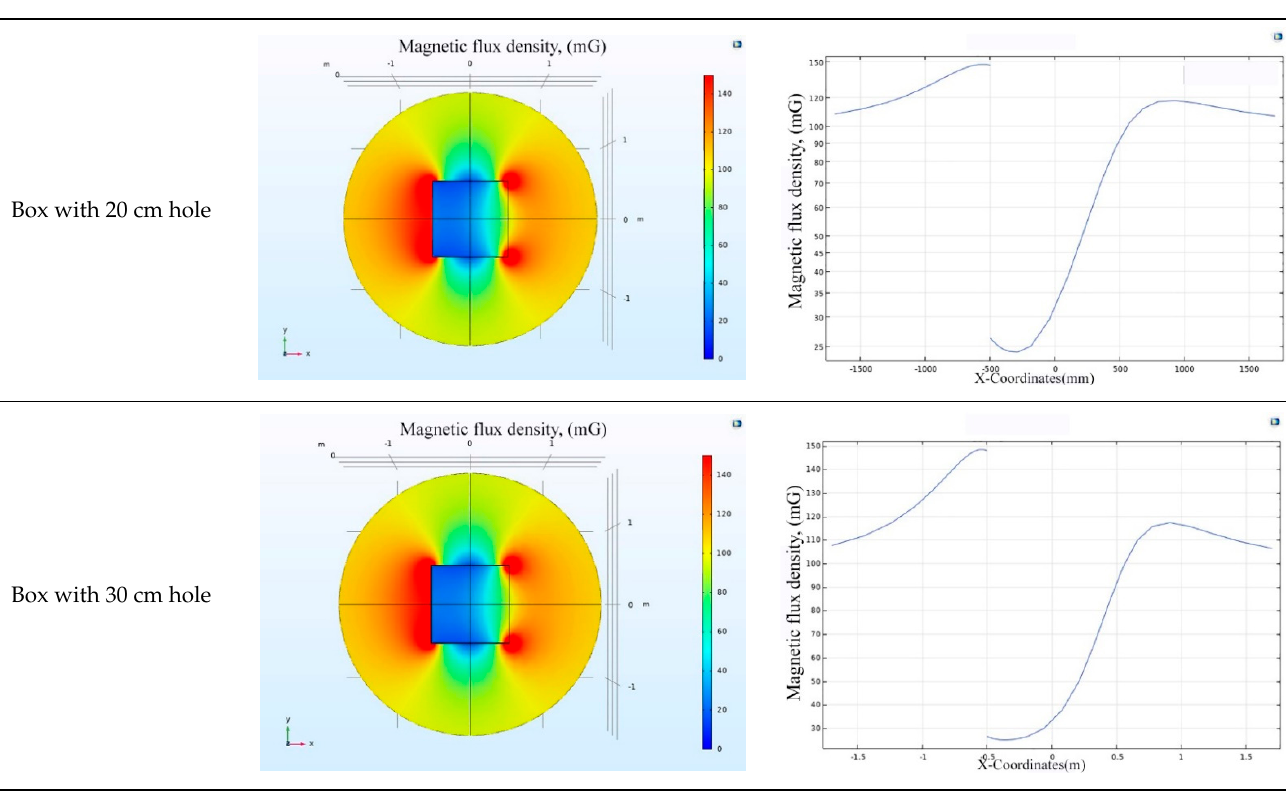
Table 6. Comparison between magnetic fields for different hole patterns.